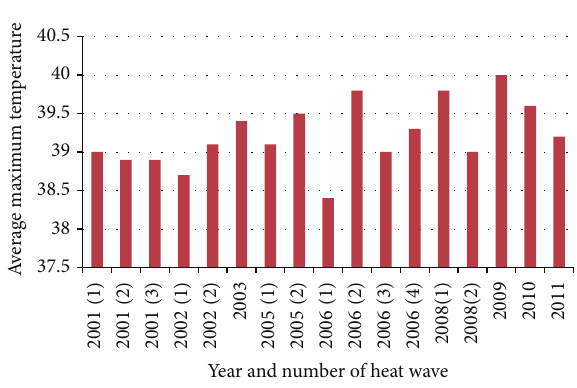
Figure 2: The average maximum temperature of heat waves in Tehran from 2001 to 2011. The number in parentheses indicates the order of the heat wave during the year. As it has been shown, three heat waves affected Tehran in 2001.